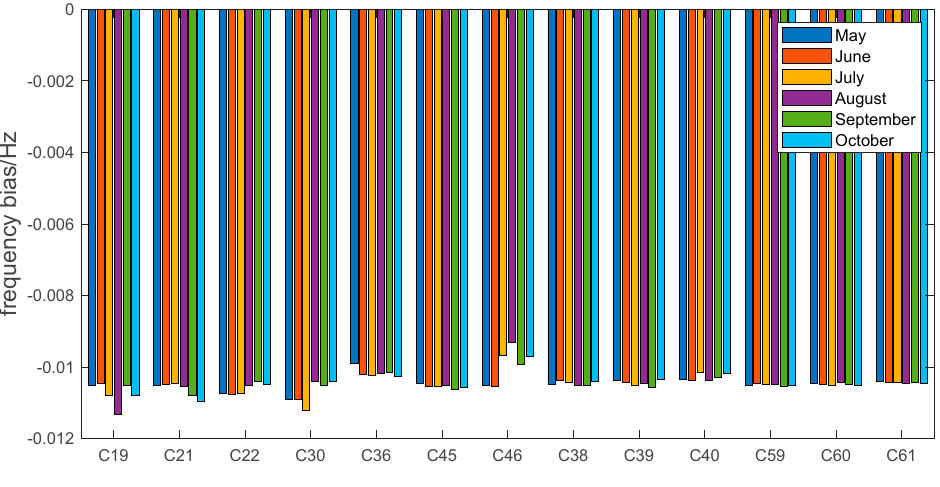
Figure 17. Frequency bias between B2a and B2b signal in 2022.